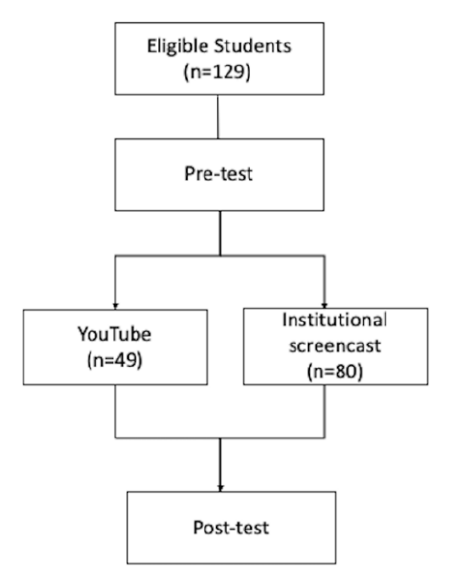
Figure 1. Study flow chart.